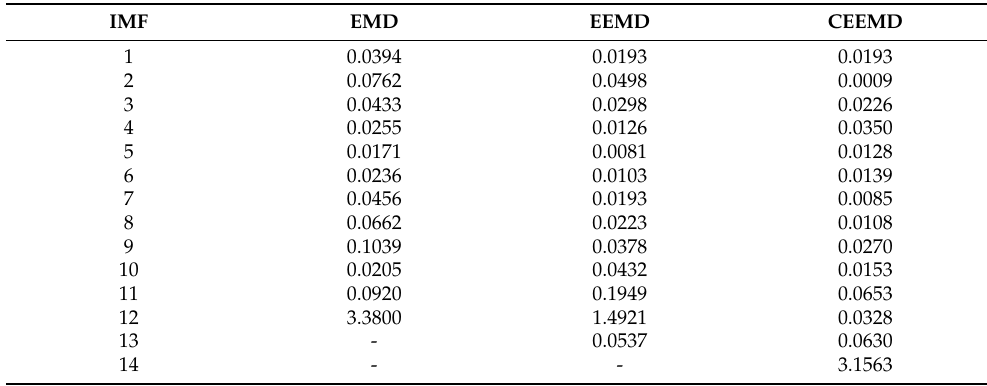
Table 2. Sensor signal per order IMF energy.